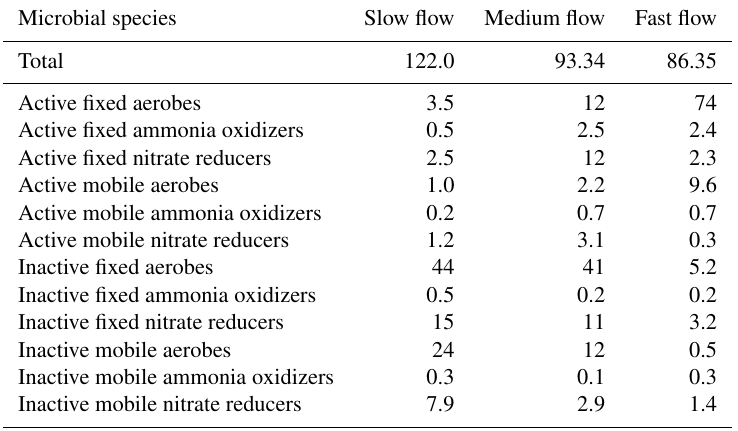
Table 4. Total biomass concentration (µMC) in homogeneous base case domains (volume averages) with fraction of biomass concentration (%) of each microbial species for three flow